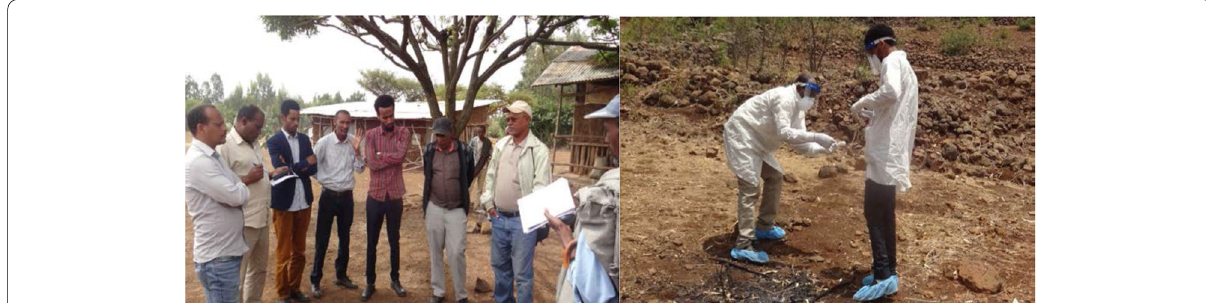
Fig. 7 Joint outbreak field investigation team discussing while anthrax outbreak investigation and Laboratory workers collect samples from the bone remains of a suspected anthrax case